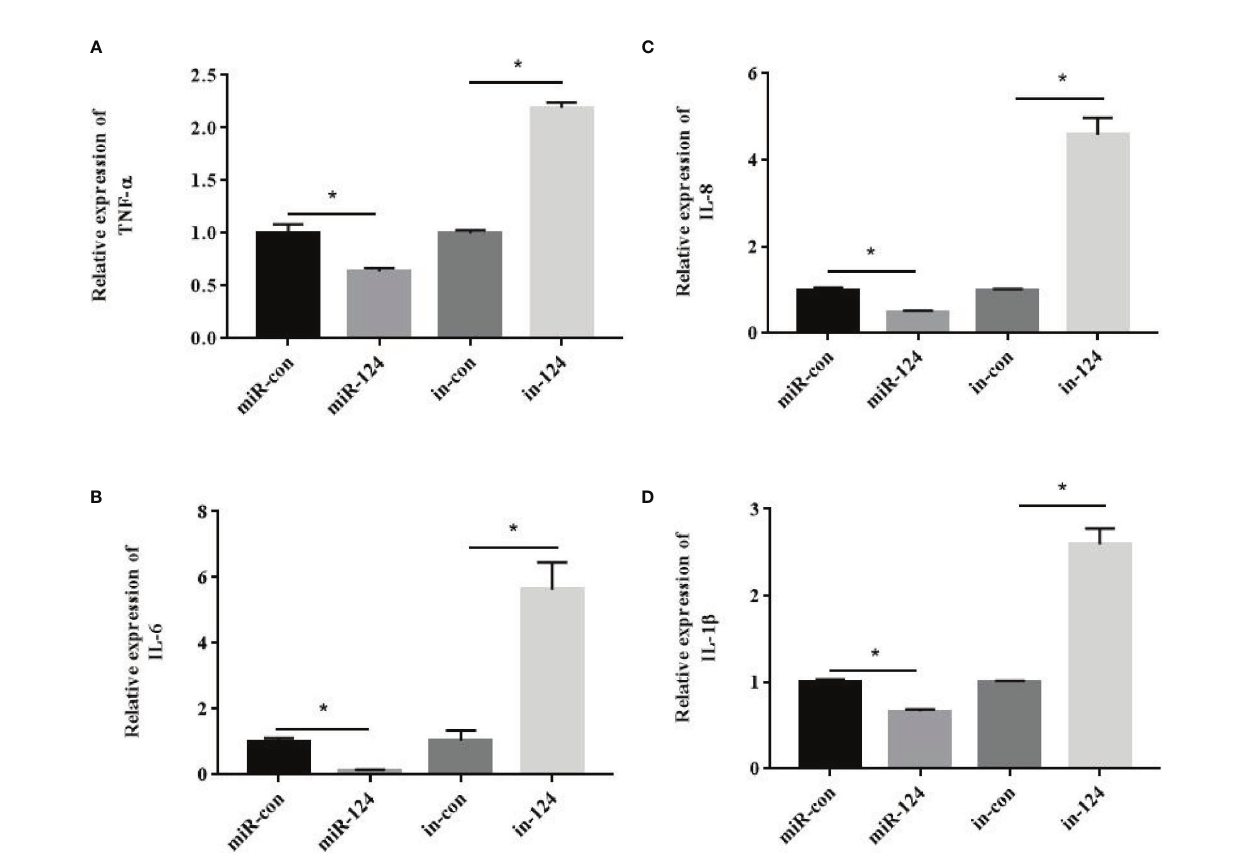
FIGURE 7 | The effect of miR-124 on the transcription of proin fl ammatory factors. b -Actin was used as internal reference. The transcription of TNF- a (A) , IL-6 (B) , IL-8 (C) and IL-1 b (D) were analyzed by qRT-PCR. control mimics: miR-con; miR-124 mimics: miR-124; control inhibitors: in-con; miR-124 inhibitors: in- 124. All data are presented as Mean ± SD, N = 4. Compared with the control group, signi fi cant difference of experimental group is indicated with *( P <